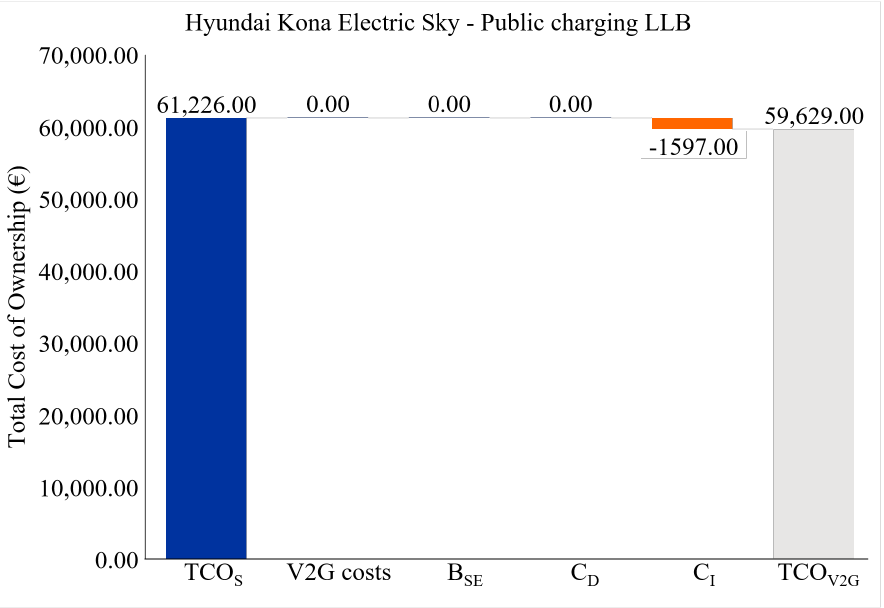
Figure A11. Standard and V2G TCO of a Hyundai Kona in a public charging case providing LLB ( TCO S = Standard TCO, B SE = benefit of saved electricity costs from the grid, C D = direct compensation, C I = indirect compensation, TCO V 2 G = V2G TCO); source: own